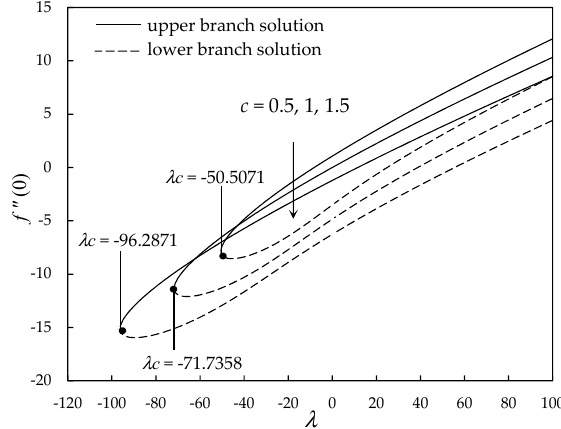
Figure 11. Variation of the reduced local Nusselt number −𝜃′(0) with the mixed convection parameter 𝜆 for several values of c (shrinking sheet) when 𝜙 = 0.01, Nr = 0.1, K = 0.1 and s = 1 for Cu-water nanofluid.